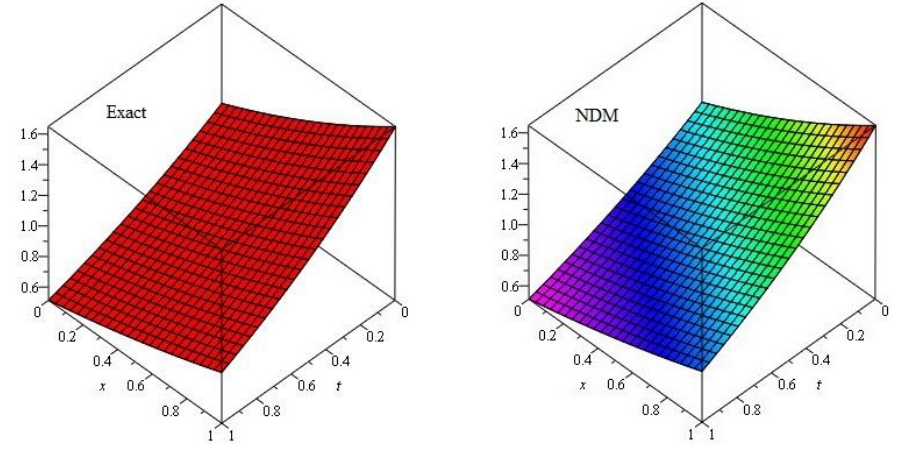
Figure 1. Exact and NDM solutions at γ = 1 of Example